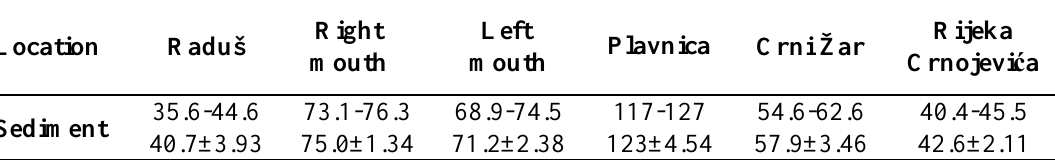
Table 1. Minimum - maximum and average concentrations ± standard deviation (S.D.) *